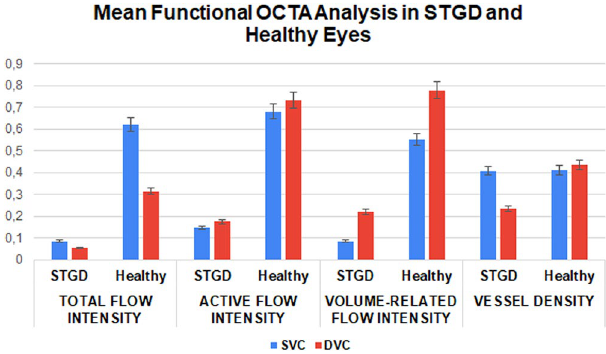
Figure 8. Mean functional OCTA analysis in STGD and healthy eyes.